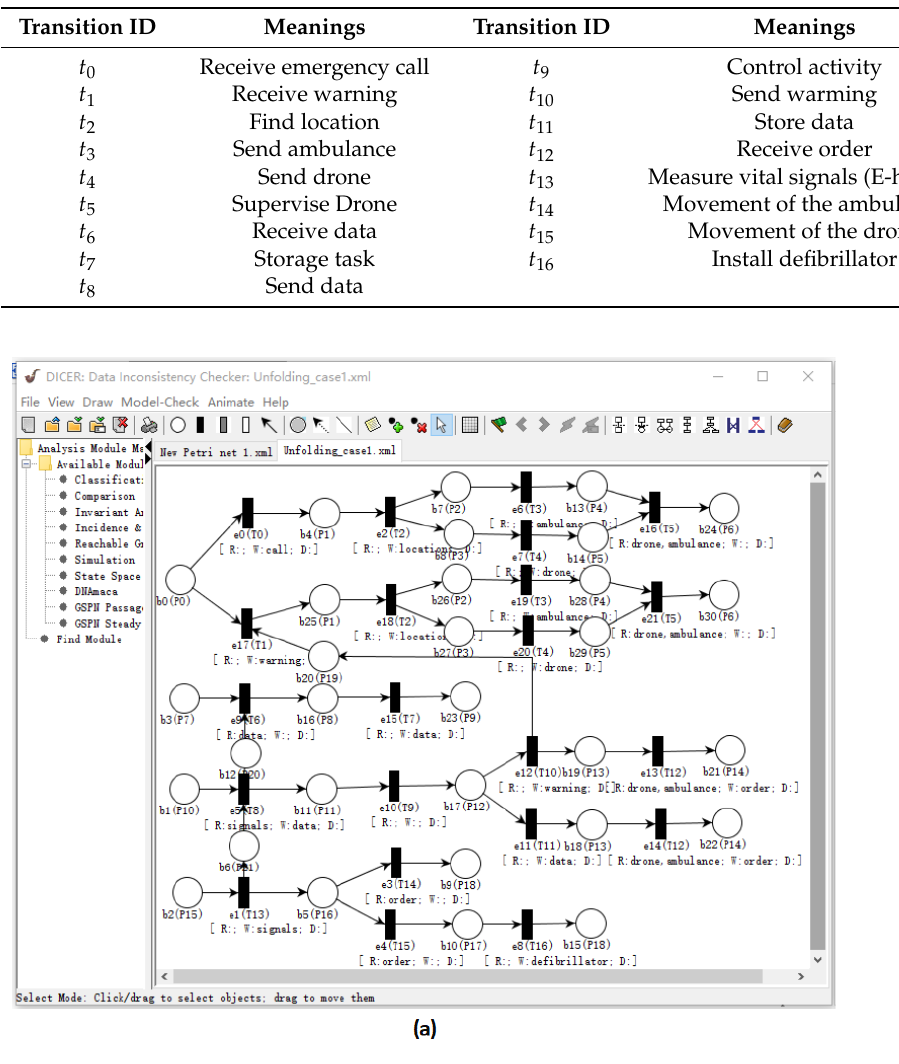
Figure 12. Detecting errors of data inconsistency based on the unfolding techniques of PD-nets; ( a ) an FCP of the PD-net in Figure 11; ( b ) the detection results.